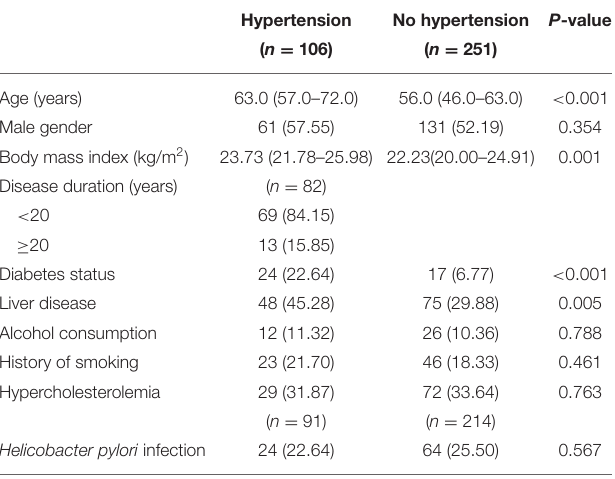
TABLE 1 | Patient demographics and clinical characteristics.